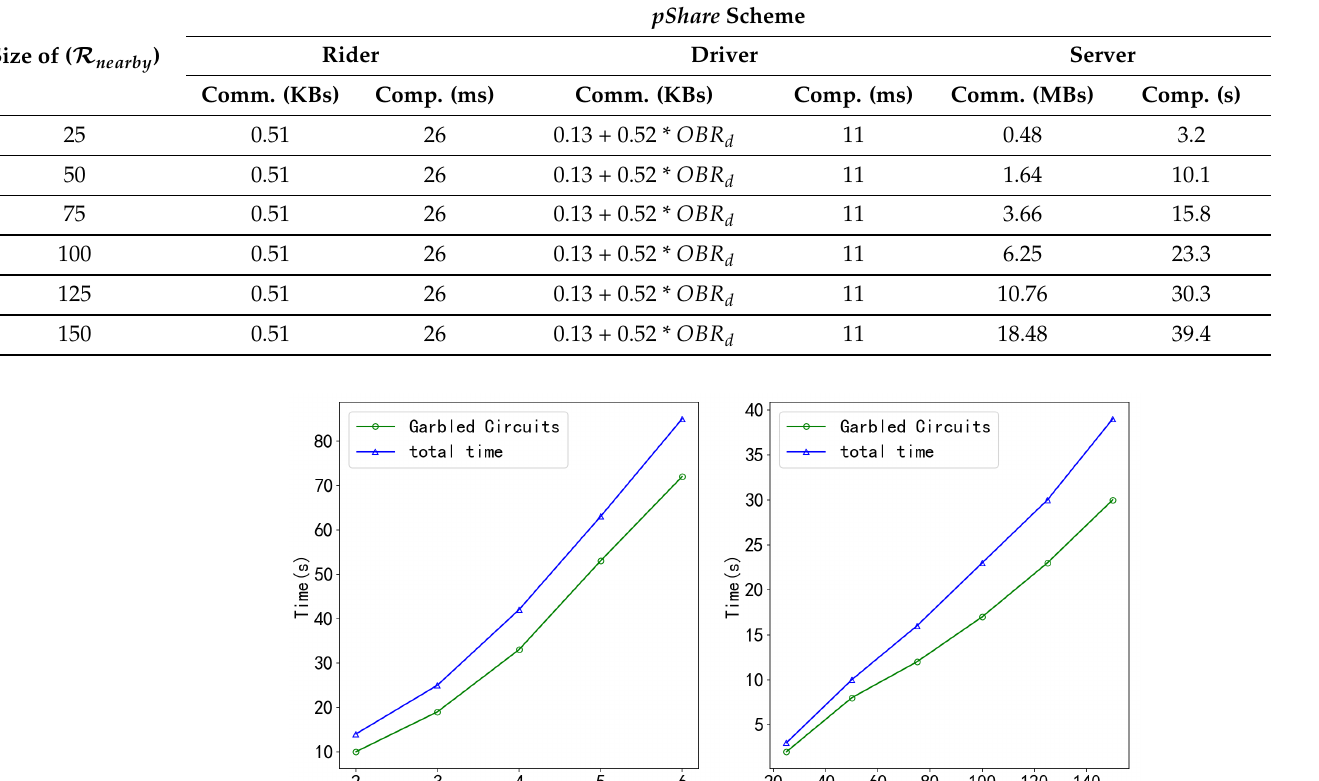
Table 2. System overhead for per ride-sharing matching under different sizes of R nearby .